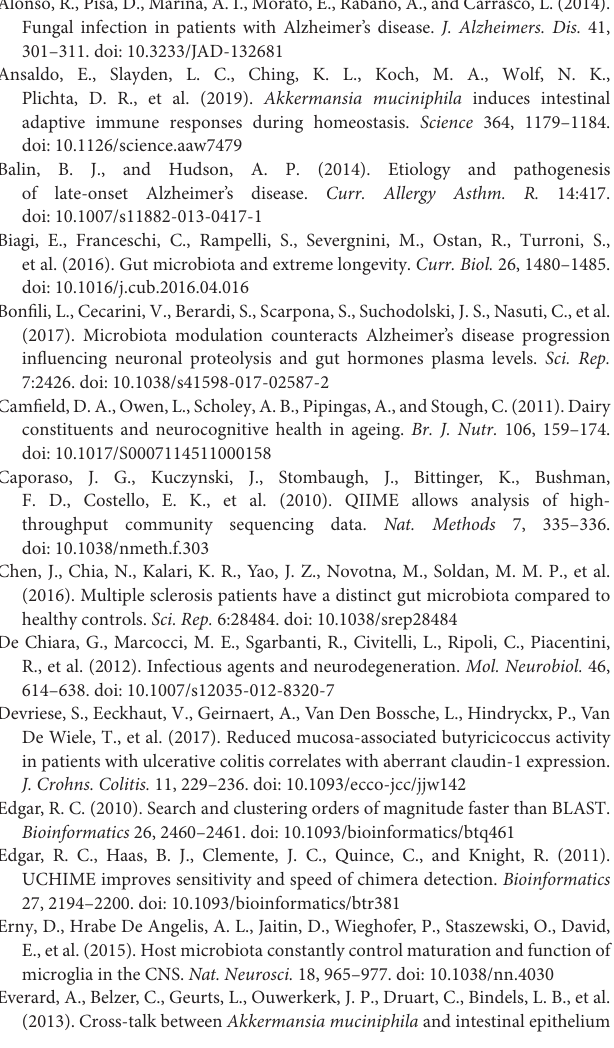
Supplementary Figure 2 | Variations in the composition of fecal microbiota in the Chinese AD patients and the healthy controls. Relative proportions of bacterial genera in AD patients ( n = 100) and healthy controls ( n = 71). Supplementary Figure 3 | Heatmap of the genus-level taxa in the fecal microbiota of the Chinese AD patients and the healthy controls. The color of the spots in the panel represents the relative abundance (normalized and log 10 transformed) of the genus in each sample. The relative abundance of the bacteria in each genus is indicated by a gradient of colors from blue (low abundance) to red (high abundance). The taxonomic classifications of the family are shown on the right. The corresponding Shannon’s index in each sample is shown under the heatmap. Supplementary Figure 4 | Mean concentrations (pg/ml) of pro- and anti-inflammatory cytokines and chemokines in patients with AD and in healthy controls determined using Bio-Plex immunoassays. The concentrations of TNF- α (A) and IP-10 (D) increased significantly in patients with AD, while those of IL-8 (B) , MCP-1 (E) , MIP-1a (F) , and IFN- γ (C) decreased significantly. ∗ p <